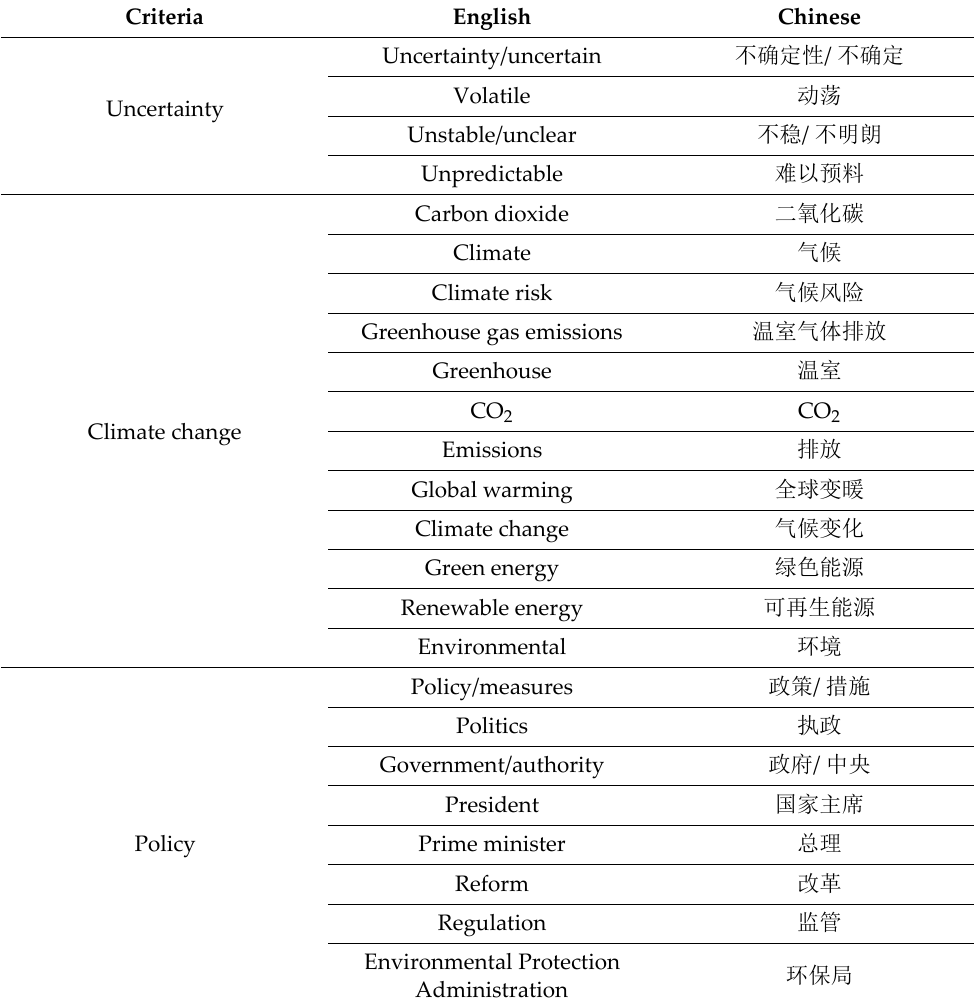
Table 1. Related Keywords.